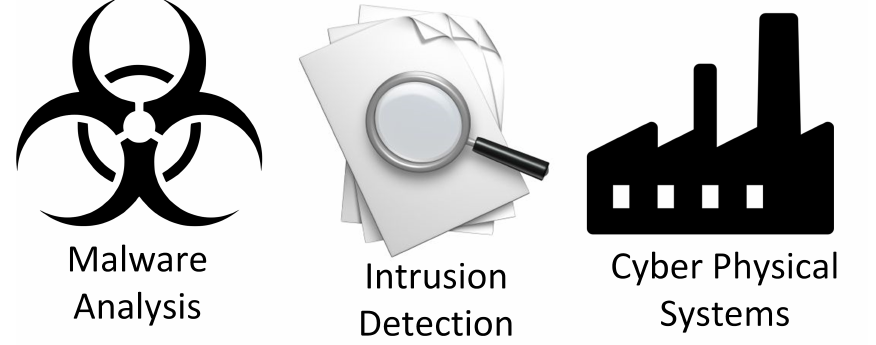
Figure 5. Common machine learning tasks in cyber